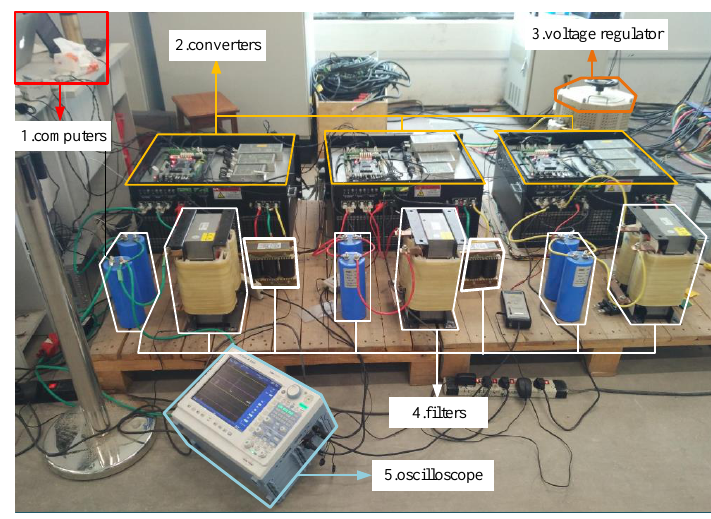
Figure 21. Experimental platform of the proposed UPQC.